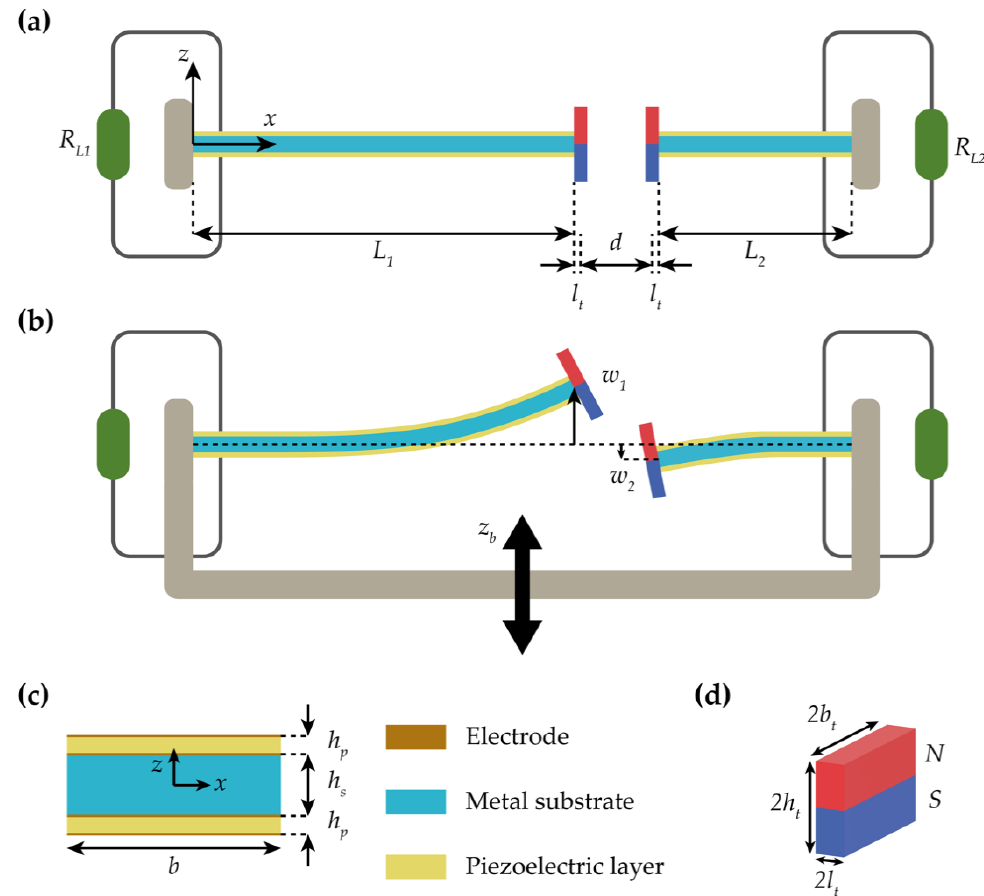
Figure 3. Geometric configurations and a schematic of motion of the 2-DOF MCBEH. Notations for geometric dimensions and coordinate system are depicted in ( a ). ( a ) shows that the external resistances are connected to the bimorph beam in series. ( b ) is a schematic of motion of the 2-DOF MCBEH in the x - z plane. The system is excited by the harmonic base displacement. The sign conventions of the tip deflections of the beams are opposite to each other. The out-of-phase motion of the beams is depicted in ( b ). ( c ) gives the magnified cross-sectional view of the bimorph beams. Each beam has the same dimensions except for the length. The thickness of the electrodes is neglected because it is too thin. The geometry of two identical neodymium magnets is shown in ( d ). The center of the magnet is considered to coincide with the centroid of the bimorph